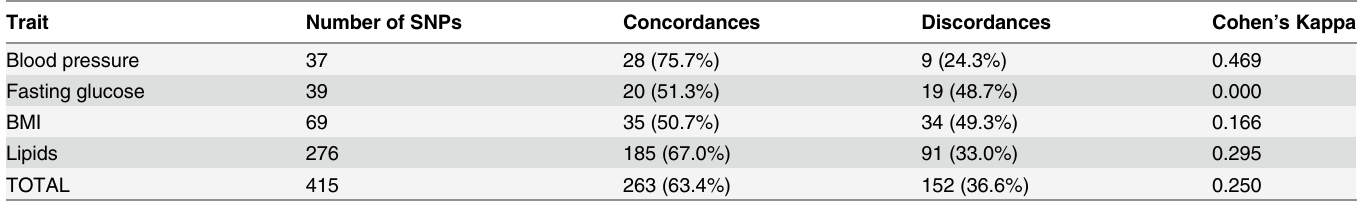
Table 1. Summary of discordances between outputs from SNAP (the HapMap 3 reference) and the Illumina Cardio-Metabochip fi le. Trait